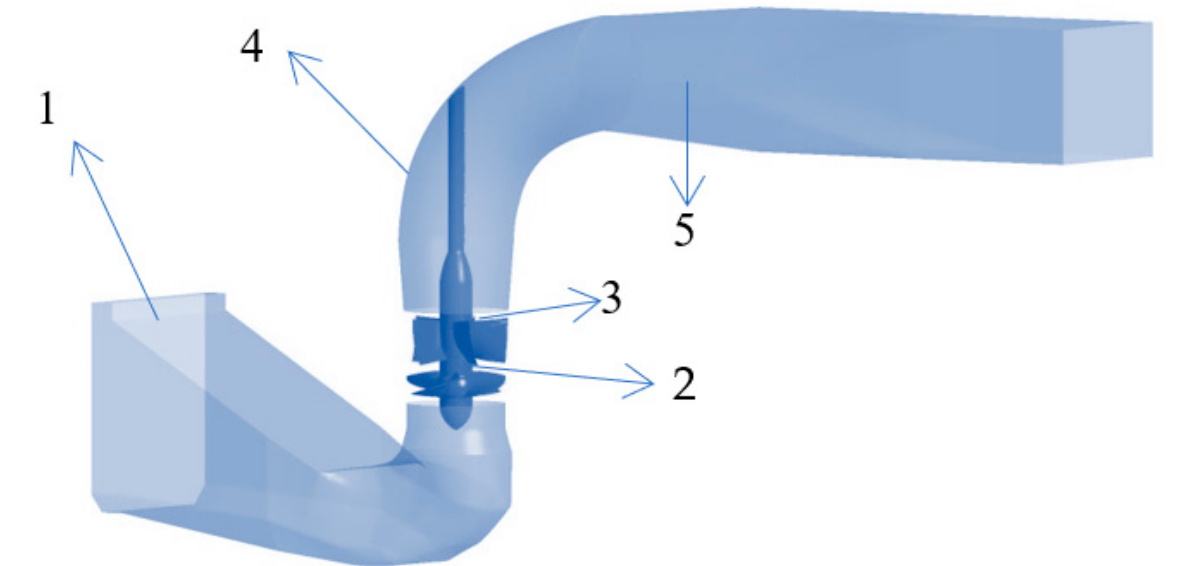
Figure 2. Three-dimensional model of the axial-flow pump device. 1. Elbow inlet conduit, 2. impeller, 3. guide vane, 4. 90° elbow, 5. straight outlet conduit.